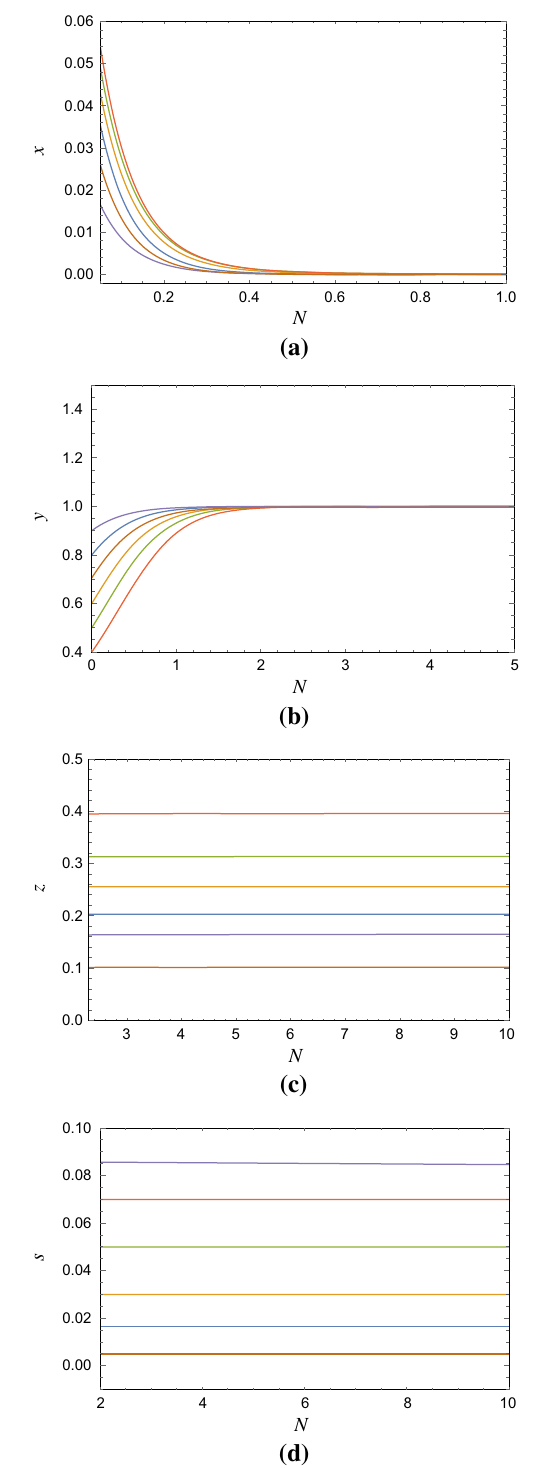
Fig. 2 Projection of the time evolution of phase space trajectories along the a x -axis, b y -axis, c z -axis and d s -axis which determine the stability of set B 2 . Here we take w = 0 and α = 0 . 6, V = V 0 φ n with n = 4 and f =